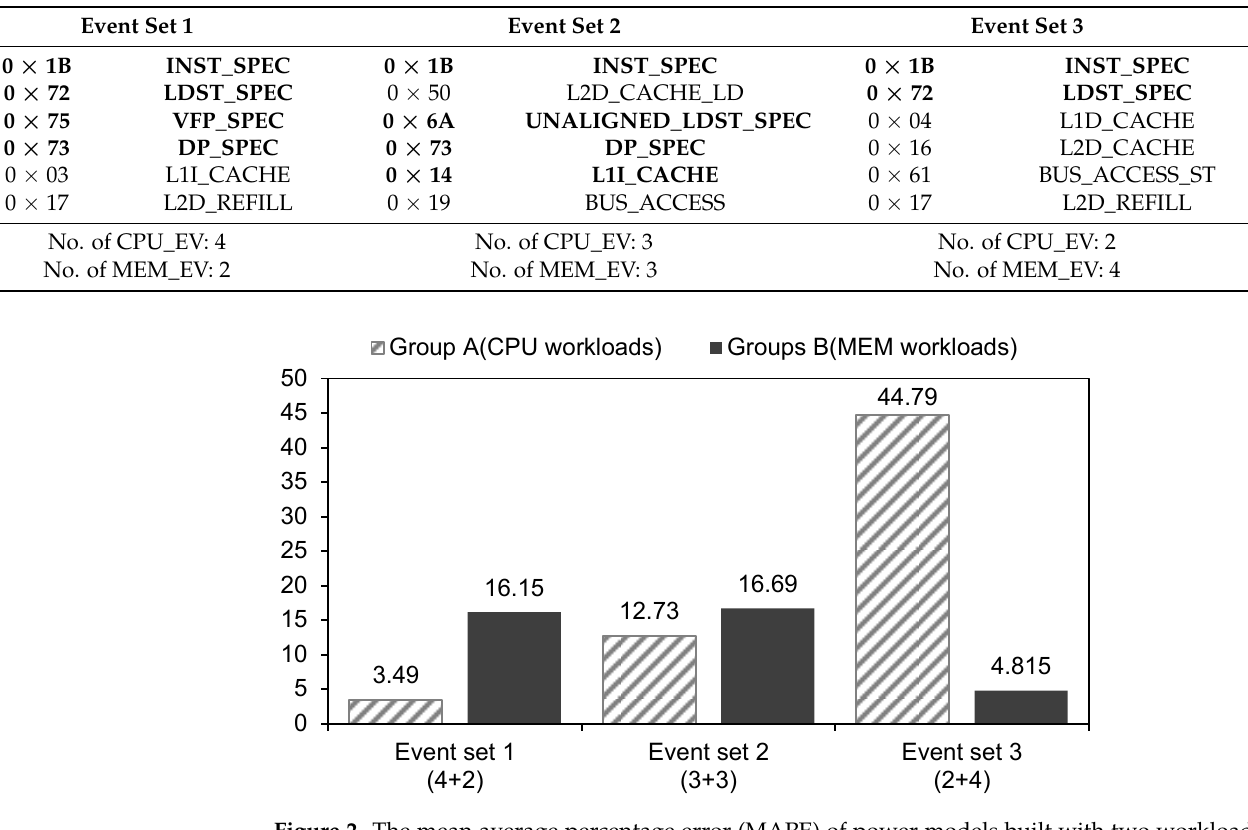
Figure 2. The mean average percentage error (MAPE) of power models built with two workload groups with the three event sets (unit: %).